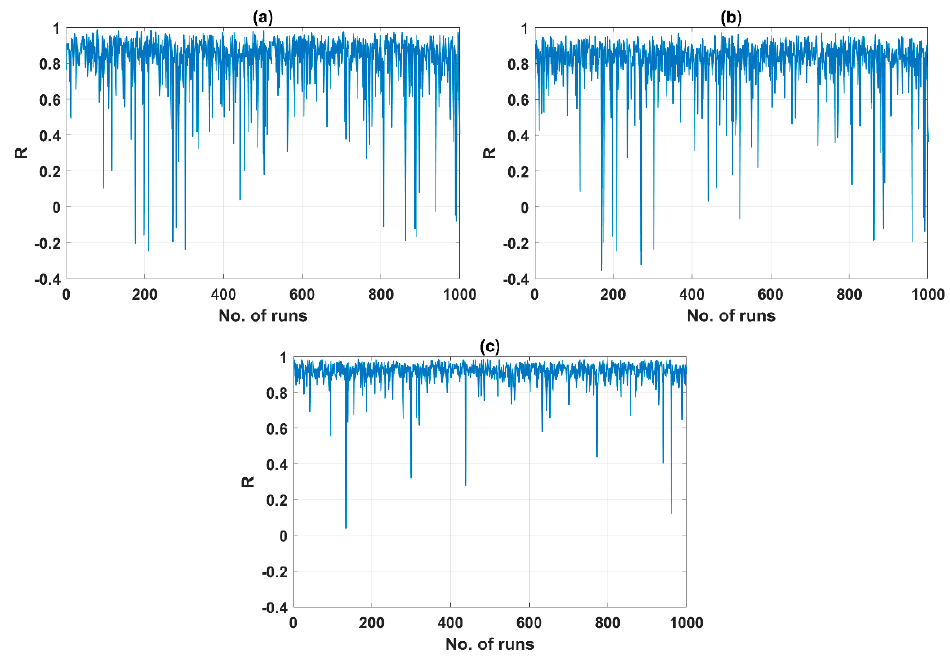
Table 5. Summary of prediction capability for the training and testing parts using PSOANFIS, GAANFIS and SVM.